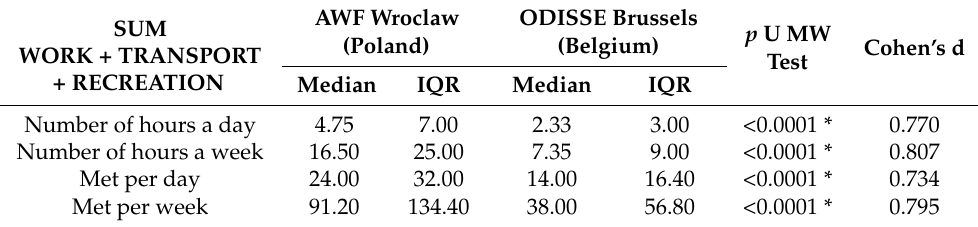
Table 10. Total score including physical activity related to work/study, traveling, and recre- ation (GPAQ).